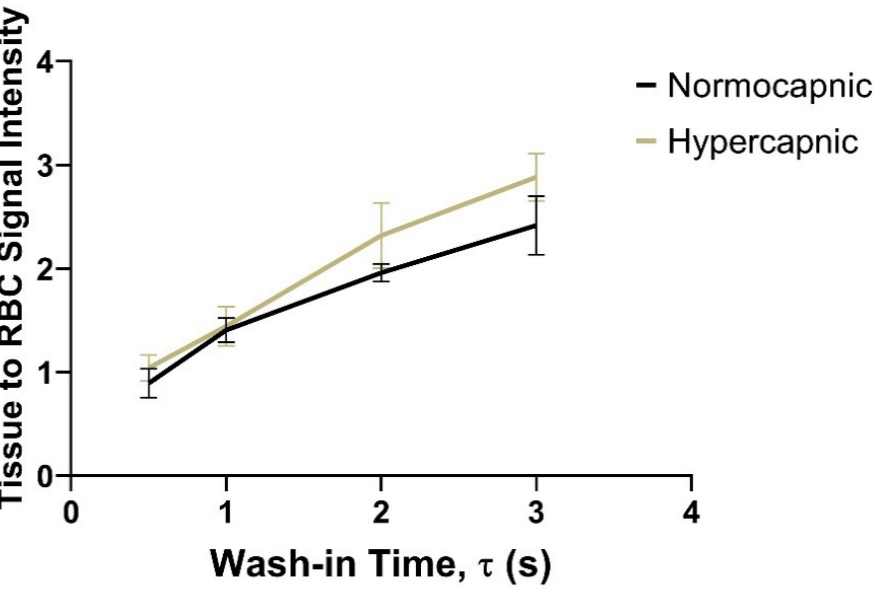
Figure 32. The ratio of tissue to RBC signal intensity in the rat brain at various wash-in times. The experiments demonstrate increased gas-transfer during hypercapnia. Reprinted with permission from Friedlander, et al. ( Magn Reson Med 2021, ref. [106]).